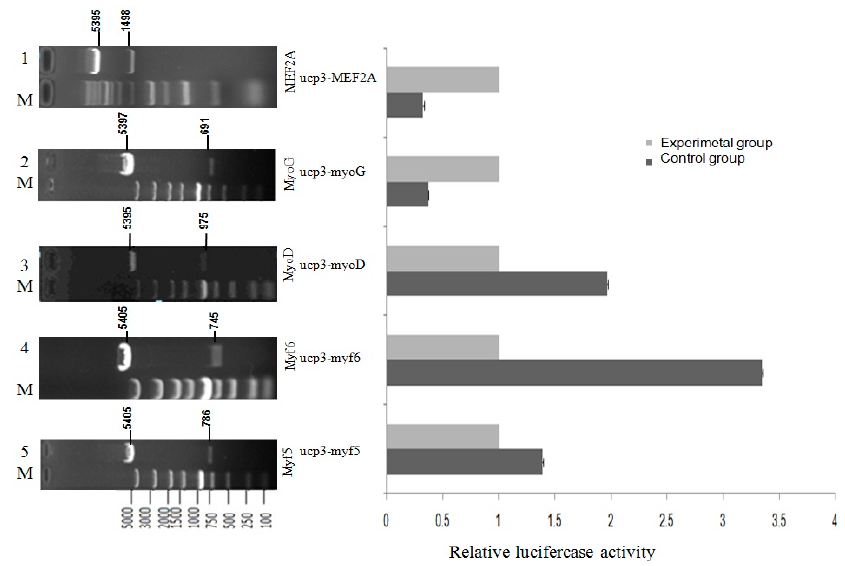
Figure 8. The effect of transcriptional activity of Guangling Cattle UCP3 promoter by MRFs family and myocyte-specific enhancer factor 2A ( MEF2A ) in C2C12 myoblasts.C2C12 myoblasts were transfected with the reporter gene constructs, pGL3-basic-ucp3-p1, pGL3-Basic, and the internal control, pcDNA3.1(+)-MRFs family and pcDNA3.1(+)-MEF2A expression vector. After 48 h, the cells were harvested for reporter gene assays. The normalized firefly luciferase activity of the experimental group was compared to that of the control group, which was transfected with an empty expression vector containing no cDNA. The control group (open bar) value was set at 1.0, with the fold induction of each group being determined. The bars represent the means ± SE of triplicate determinations.